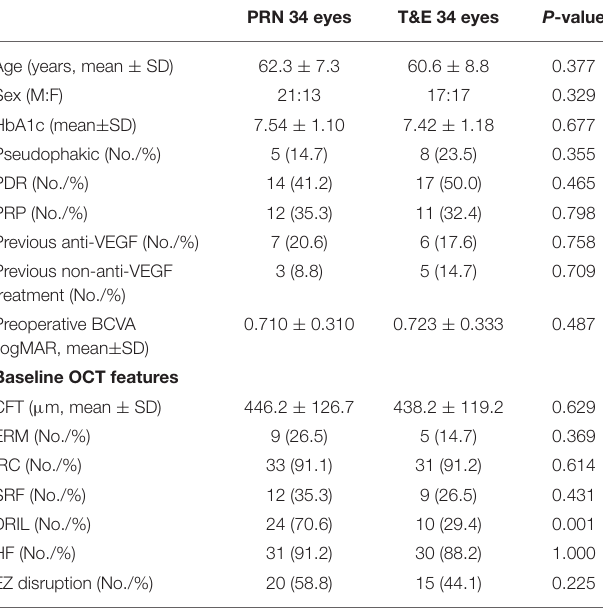
TABLE 1 | Baseline characteristics and optical coherence tomographic findings of patients with diabetic macular edema who underwent anti-vascular endothelial growth factor therapy using pro re nata or treat-and-extend protocol.